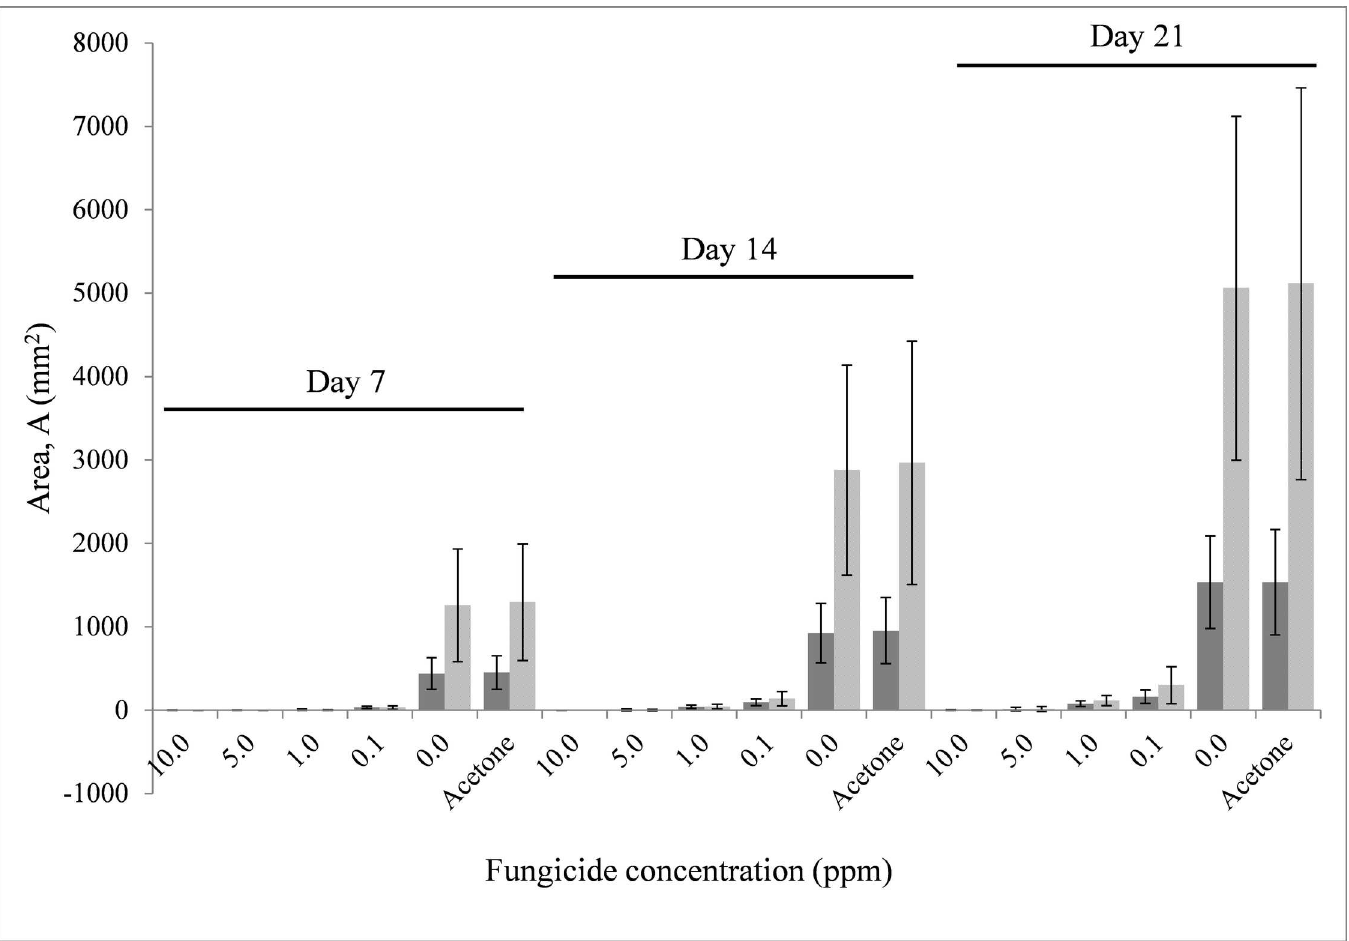
Fig 3. Area of fungal growth measured, M A (dark bar) or calculated, D A (light bar) from averagediameter for Days 7, 14 and 21 for each fungicide level tested. The error-bars are the 95% confidenceintervals for each